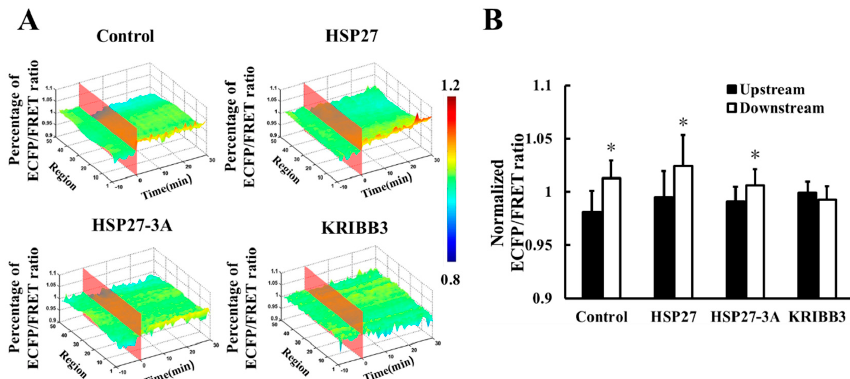
Figure 5. Effect of HSP27 on shear-stress-induced Cyto-FAK polar activation. ( A ) The 3D distribution of FRET ratio for the control, HSP27, HSP27-3A, and KRIBB3 groups with 20 dyn/cm 2 shear stress stimulation. ( B ) Comparison of Cyto-FAK FRET ratio between upstream and downstream in the control, HSP27, HSP27-3A, and KRIBB3 groups upon 30 min of 20 dyn/cm 2 shear stress application (* p < 0.05 when comparing to the upstream; values are from the 30 min time point).